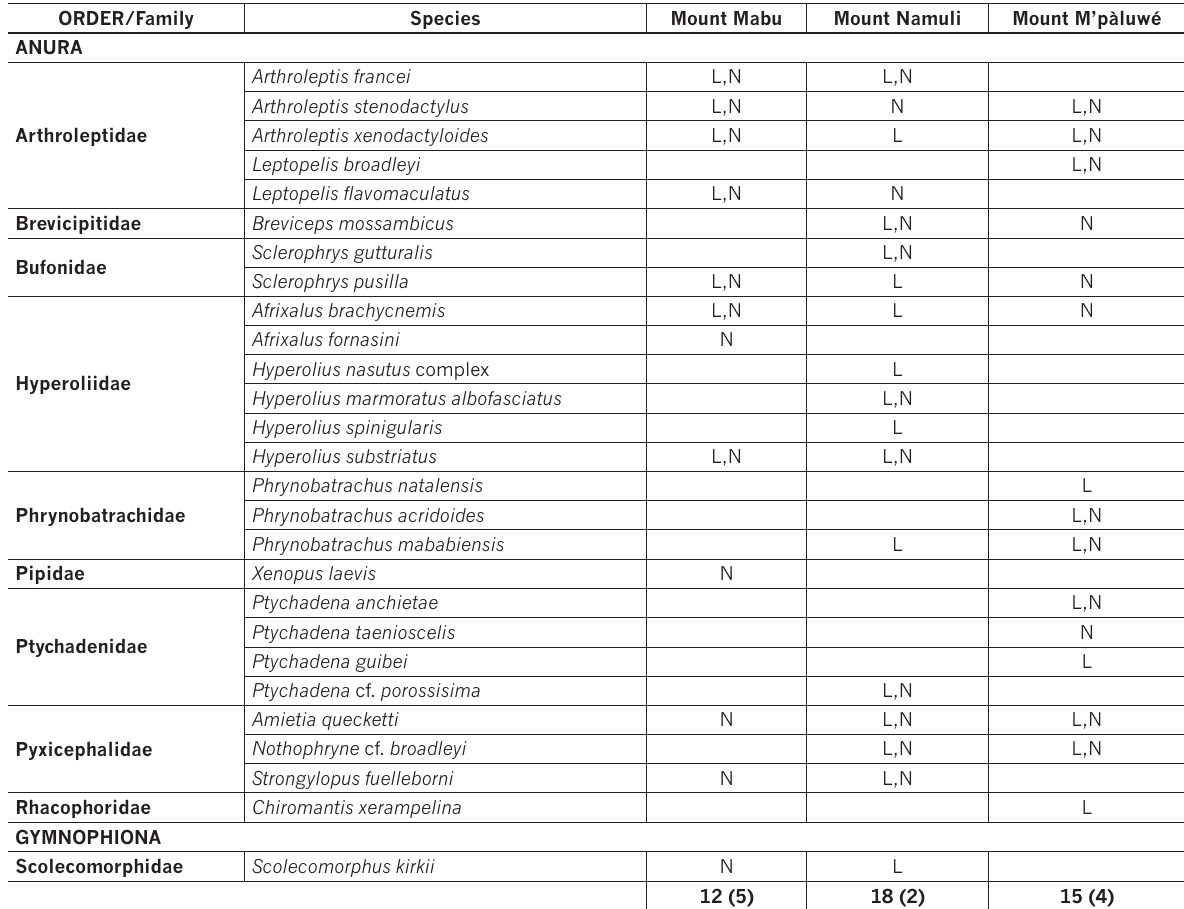
Table 2. Updated species lists for amphibians based on historical records as well as data from the current surveys. Parentheses in the totals given denote the number of new species recorded during the current surveys. Literature records are indicated with L and new records with